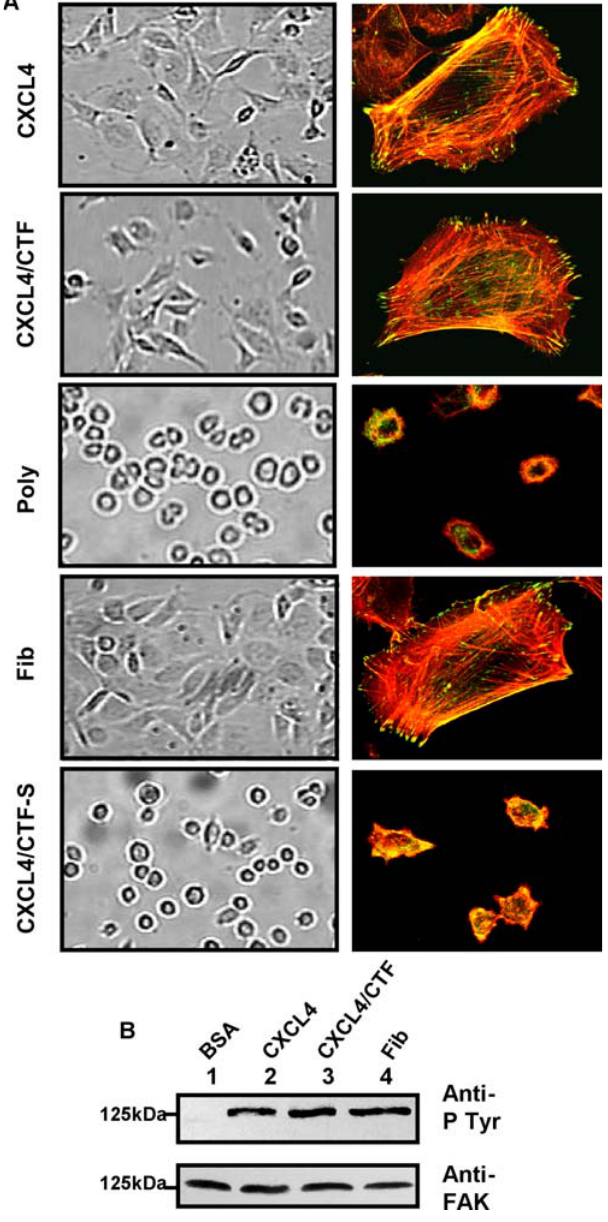
Figure 1. Immobilized CXCL4 or CXCL4/CTF promotes human umbilical vein endothelial cells (HUVECs) spreading, focal adhesion and stress fiber formation. (A) Analysis of spreading, focal adhesion and stress fibers. HUVECs were plated for 4h on coverslips that had been coated with (25 m g/ml) CXCL4, (25 m g/ml) CXCL4/CTF, (100 m g/ml) fibrinogen, (25 m g/ml), CXCL4/CTF-S and (100 m g/ml) poly-D-lysine. After washing, the cells are fixed. The degree of cell spreading is seen from the phase contrast micrographs (left side) Then the cells were permeabilized and stained to visualize focal adhesion (vinculin staining, green), and actin stress fibers (Rhodamin- Phalloidin staining, red) by confocal microscopy (right side). (B) Analysis of tyrosine phosphorylation of FAK. Effect of HUVEC cell adhesion to CXCL4 or CXCL4/CTF on tyrosine phosphorylation of FAK. HUVECs were maintained in suspension for 60 min (BSA, lane 1) or allowed to attach to integrins ligand (fibrinogen, lane 4) or CXCL4 (lane 2) or CXCL4/CTF (lane 3). Cells lysates containing equal amounts of protein were immunopre- cipitated with anti-FAK antibody. One half of immunoprecipitates was subjected to immunoblotting with anti-phosphotyrosine mAbs, 4G10, and PY20, and the other half was probed with mAb anti-FAK.